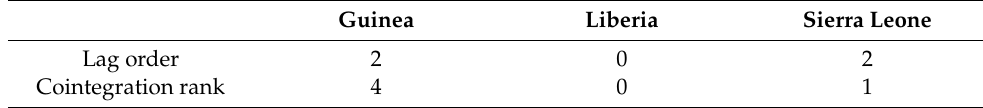
Table 4. Lags order and cointegration ranks. Guinea Liberia Sierra Leone Lag order 2 0 2 Cointegration rank 4 0